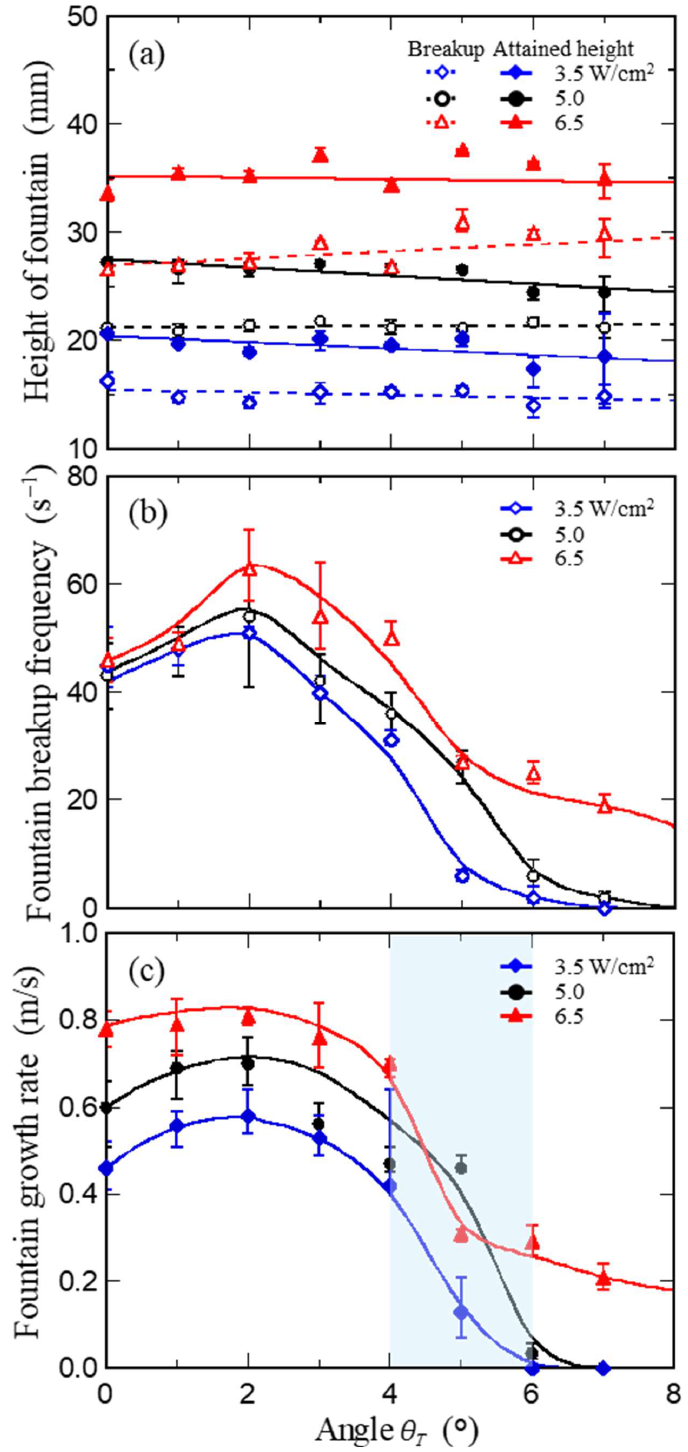
Figure 4. Effects of transducer setting angle on ( a ) breakup and attained heights, ( b ) breakup frequency, and ( c ) growth rate of liquid fountain for input power densities of 3.5, 5.0, and 6.5 W/cm 2 .